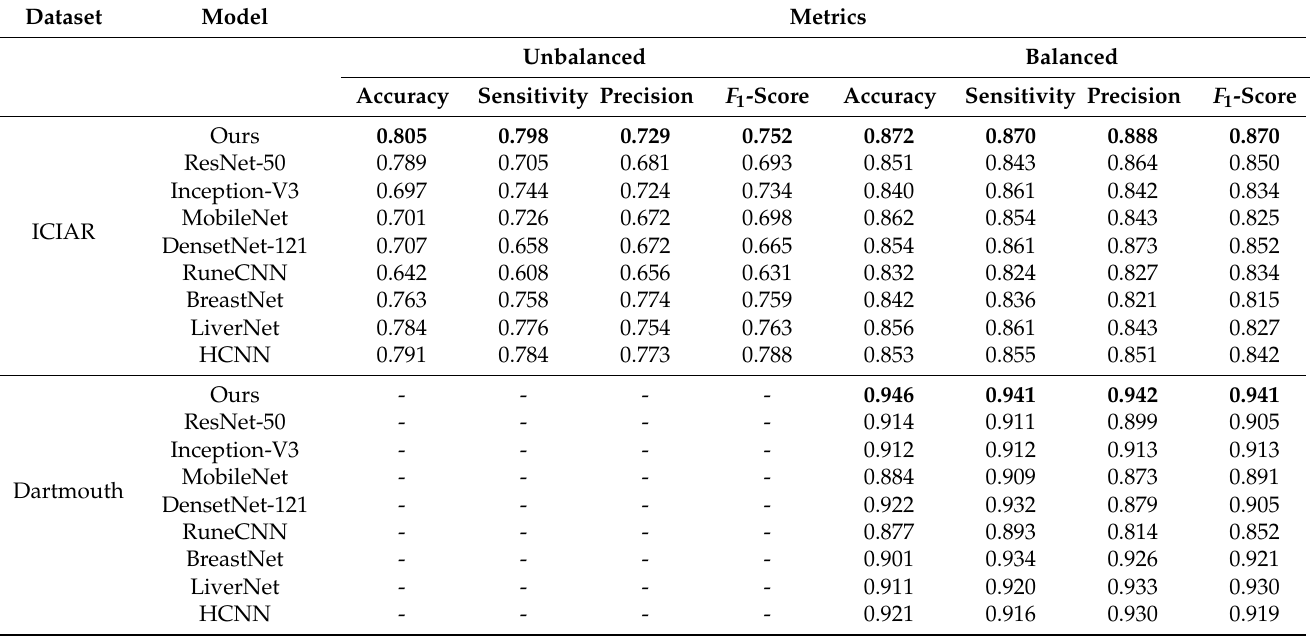
Table 6. Comparison of four metrics on the ICIAR2018 and Dartmouth datasets for the multi- classification. The best results are shown in bold